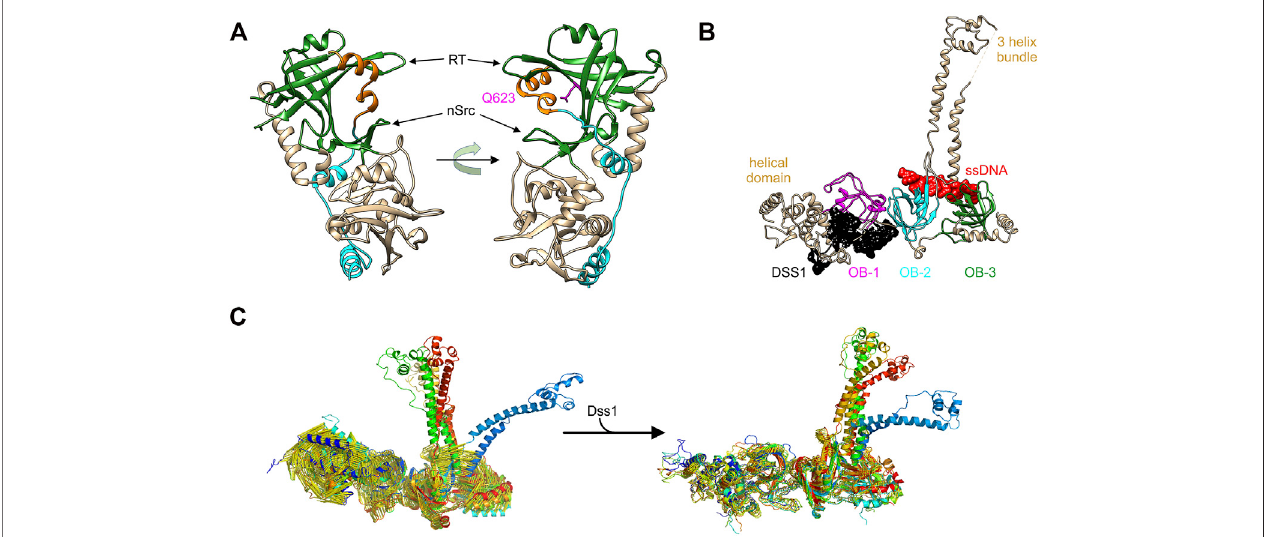
FIGURE 5 | OB-folds bind to protein and DNA separately to control protein function. (A) The POT1-TPP1 complex (PDB fi le 5UN7). The third OB-fold of POT1 is colouredingreenandtheregionoftheTPP1-POT1bindingdomainthatsitsinthecanonicalssDNA-bindinggroovesiscolouredorange.Theorientationoftheimageon theleftpositionstheOB-foldtoapositionsimilartothatoftheOB-foldsin Figure3 .Theimageontherightisrotatedtoshowthelocationofthe3 10 -helixinitsbindingsite and the position of Q623 (pink). (B) The structure of the three OB-folds and tower domain of BRCA2 are shown in complex with ssDNA (red) and DSS1 (black) (Yang et al., 2002) (PDB fi le 1MJE). (C) Molecular dynamics simulations of the apo-BRCA2 complex (left) and of the complex following DSS1 binding (right). These high- resolution images were provided by Dr. Bahadur, IIS, Kharagapur, India (Alagar and Bahadur 2020).